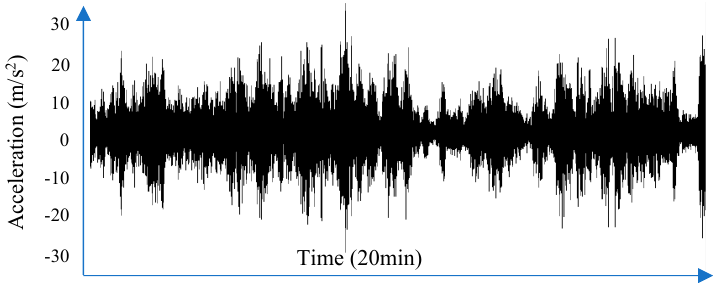
Figure 6. Acceleration signals at the reference point of M0.